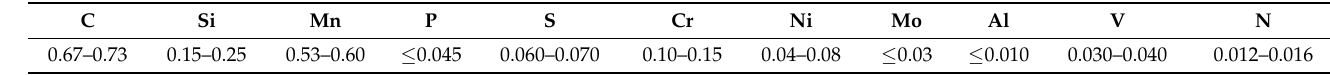
Table 1. Chemical composition of steel C70S6,